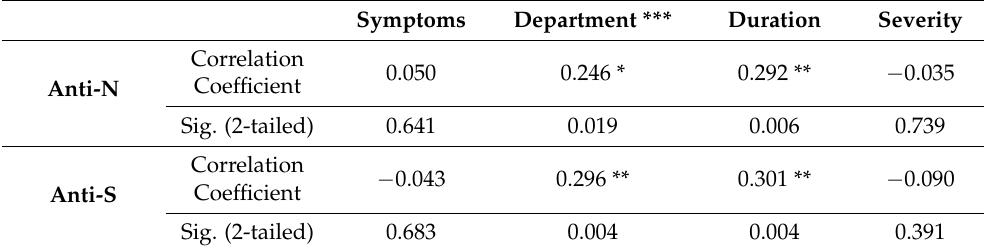
Table 5. Correlations between antibody titers and symptoms, department, duration, and severity of symptoms in the naturally infected unvaccinated